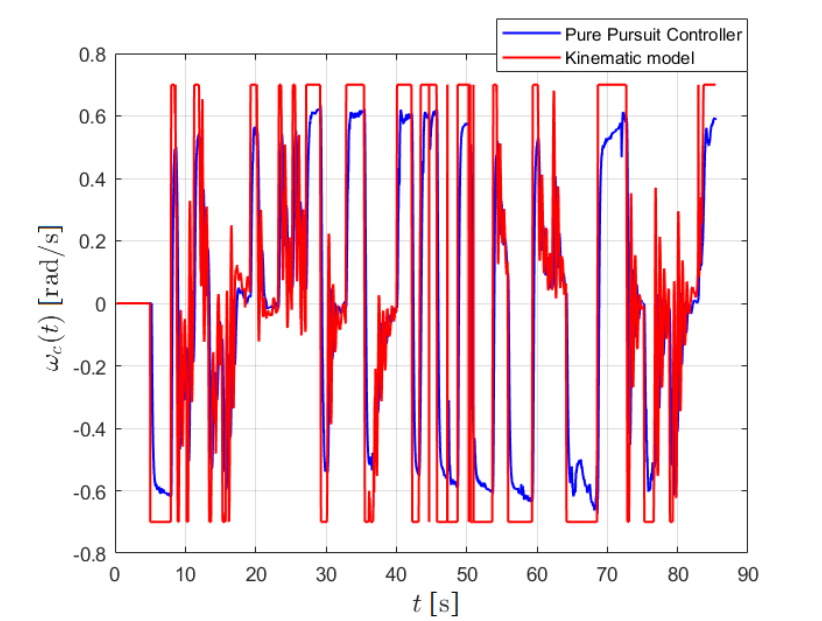
Figure 32. Angular velocity ω c ( t ) of the QBot 2e robot. The third generated map with the mapping of the path using the RRT algorithm is presented below. Figures 34 and 35 present the linear and angular velocity of the robot. They were determined on the basis of odometric data and the kinematic